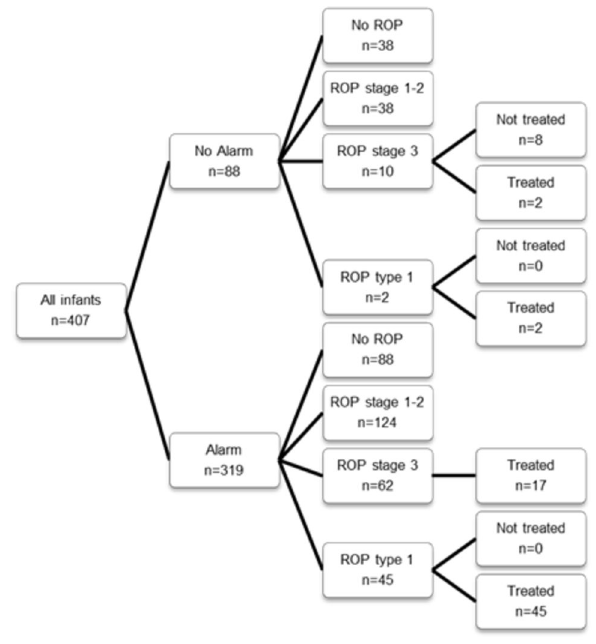
Figure 2. Flowchart of WINROP outcomes.